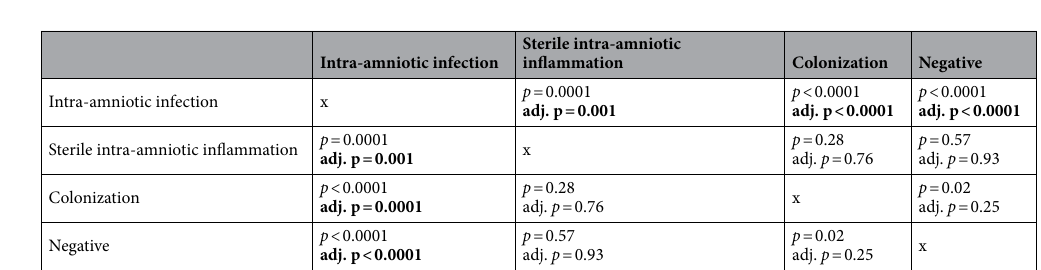
Table 7. IgGFc-binding protein in cervical fluid from preterm prelabor rupture of membranes: the comparisons among the subgroups of the women with intra-amniotic infection, sterile intra-amniotic inflammation, colonization, and negative amniotic fluid. p -value: a comparison between two subgroups (a nonparametric Mann–Whitney U test); adj. p -value: a comparison between two subgroups after the adjustment for gestational age at sampling (a Spearman partial correlation). Statistically significant results are marked in bold.